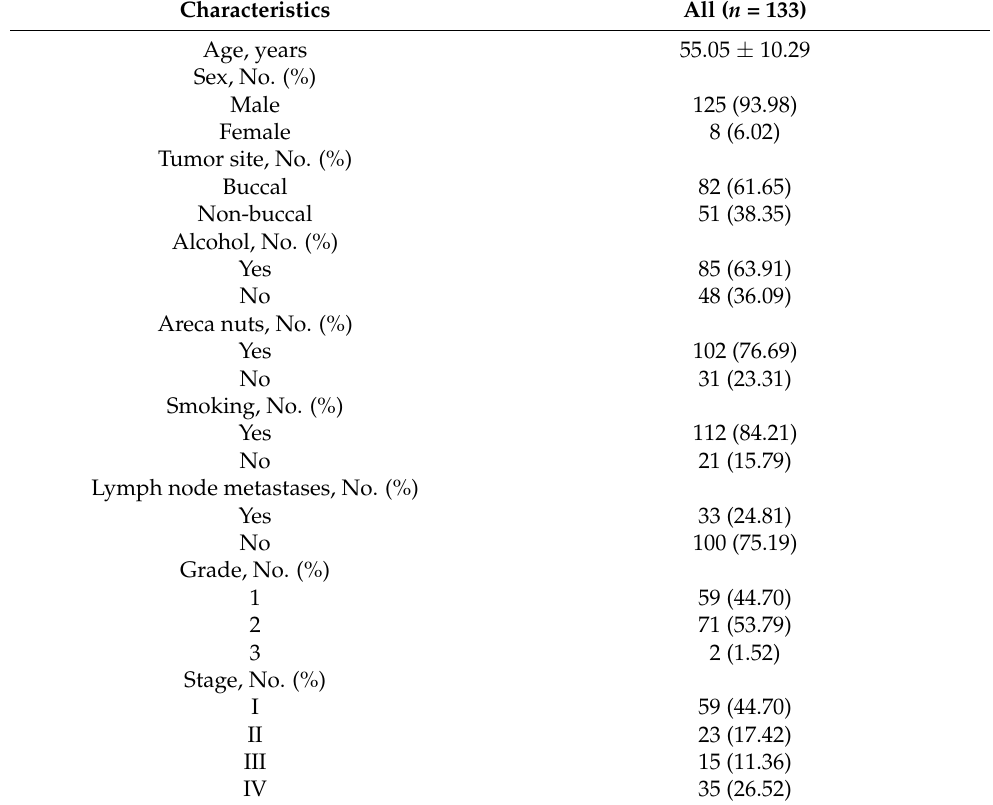
Table 1. Characteristics of patients with oral cavity squamous cell carcinoma.